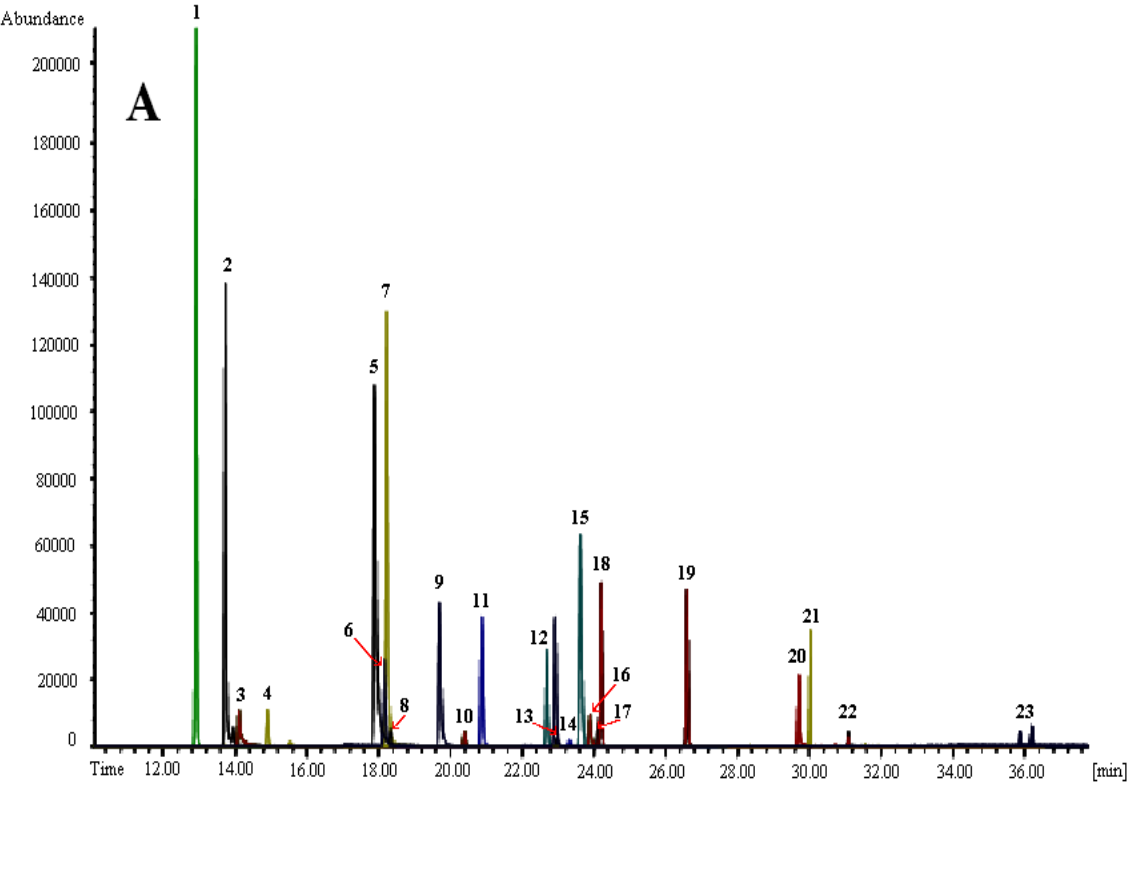
Figure 1. Chromatograms of target ions of 23 endocrine disrupting pesticides analyzed by capillary GC-MS in SIM mode on the conventional column HP-5 MS, 30 m × 0.25 mm I.D. × 0.25 µm connected to non-polar deactivated precolumn (1 m × 0.32 mm I.D.) in matrix-matched standard solutions at the concentration level of each analyte 10 ng/mL (corresponding to 10 µg/kg): A — NCI mode; B — EI mode